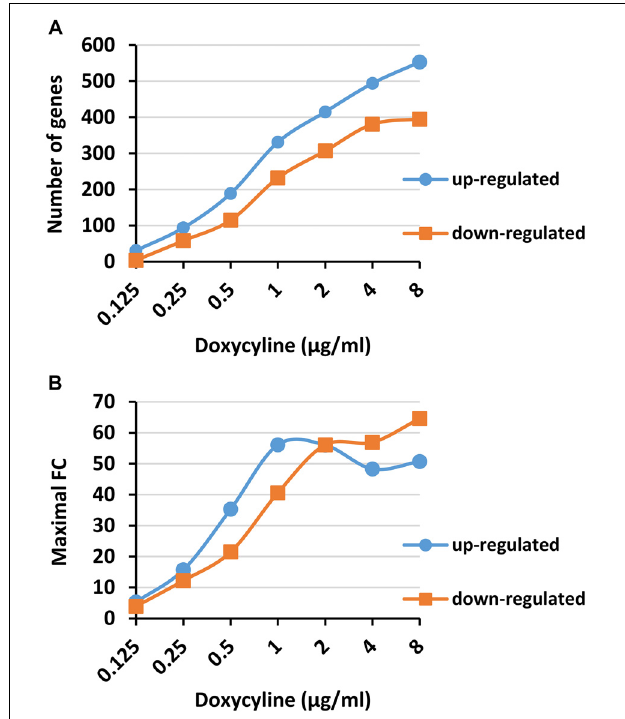
FIGURE 1 | Dose-dependent expression of Yersinia pestis genes upon exposure to doxycycline. Y. pestis Kim53 bacteria were exposed for 2 h to the indicated concentrations of doxycycline. After 2 h, the bacteria were harvested and subjected to transcriptomic analysis using a custom Agilent DNA microarray. (A) The number of genes that were upregulated (blue circle) or downregulated (orange square) by at least threefold upon exposure to doxycycline. (B) The maximal change in expression levels that was observed at each doxycycline concentration in the upregulated (blue circle) or downregulated genes (orange